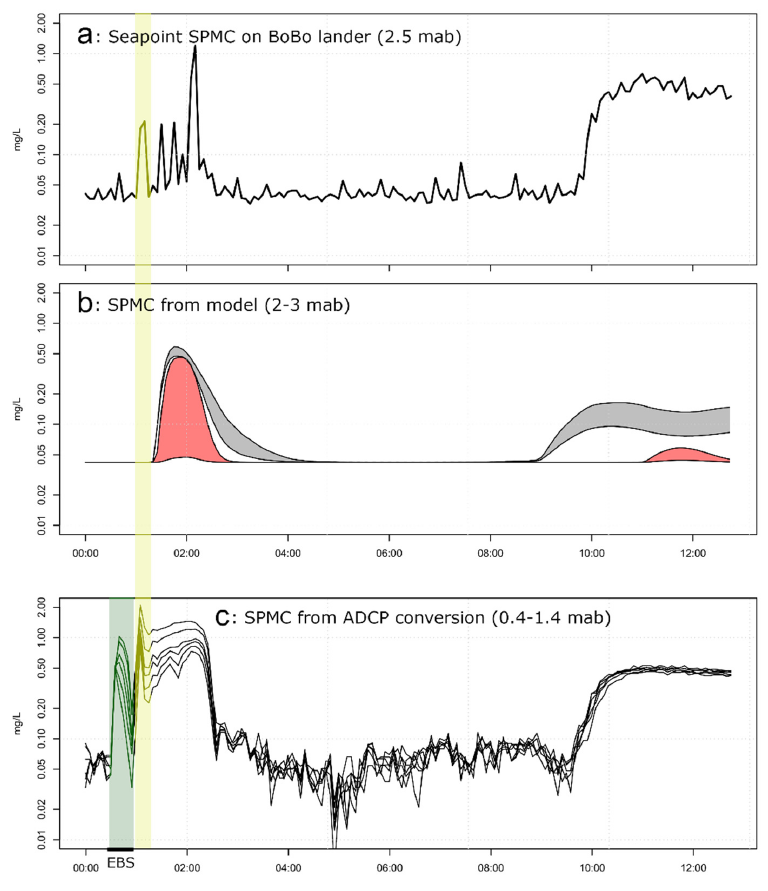
Figure 7. ( a ) Time series of SPMC measured at 2.5 mab by the Seapoint sensor on the BoBo lander, during the EBS experiment on August 5th, 2015. The plume was detected twice (E1 and E2). The first peak marked by yellow shading was probably produced by the EBS towing cable sweeping over the seafloor. ( b ) Modelled SPMC time-series for the 2–3 mab vertical model grid cell corresponding to the position of the Seapoint sensor on BoBo. The grey and red shaded areas refer to the SPMC simulated while implementing the real bathymetry or assuming a horizontal seafloor, respectively. The lower and upper bounds of the shaded areas represent simulations for release heights of 0–1 mab and 1–2 mab, respectively. ( c ) Time series of SPMC derived from acoustic backscatter recorded with the downward-looking 1200 kHz RDI ADCP mounted on the BoBo lander, for 6 vertical depth bins centred, respectively, at 0.4, 0.6, 0.8, 1.0, 1.2 and 1.4 mab. The first peak in the ADCP-SPMC marked by green shading is related to the underwater noise created by towing the EBS (black line). Peaks produced by the towing cable and EBS noise are obviously not reproduced by the model